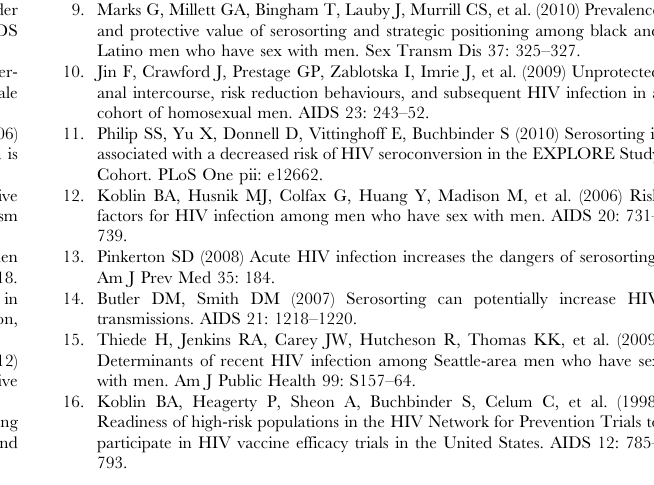
Table S1 Adjusted relative hazards of HIV seroconver- sion among North American men who have sex with men from four longitudinal cohort studies,